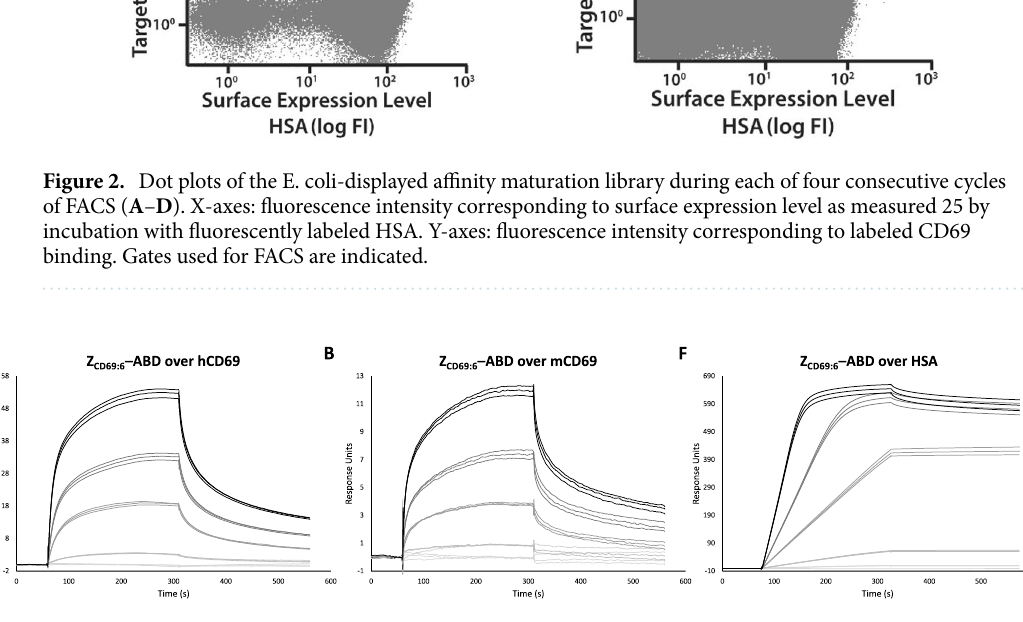
Figure 3. Representative series of SPR sensorgrams showing the binding of affinity maturated Affibody molecule, in this case H 6 -Z CD69:6 -ABD, to ( A ) human CD69, ( B ) murine CD69 and ( C ) human serum albumin at different concentrations (1 nM, 5 nM, 25 nM, 50 nM and 100